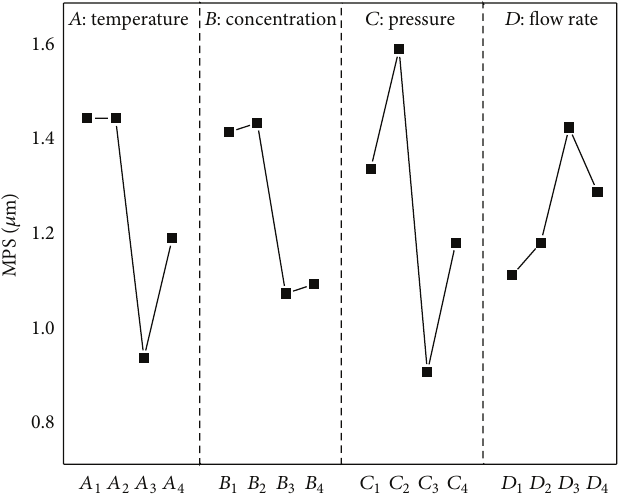
Figure 3: The effect of each parameter on the particles size of u-Res ( 𝐴 is temperature, 𝐵 is concentration, 𝐶 is pressure, and 𝐷 is flow rate).